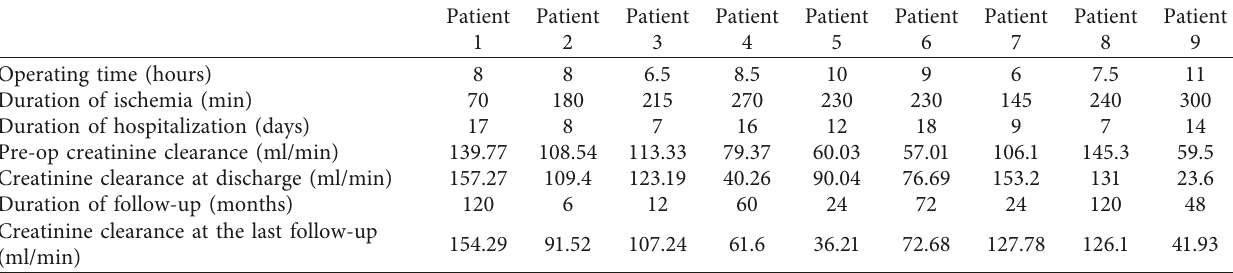
Table 2: Perioperative and postoperative